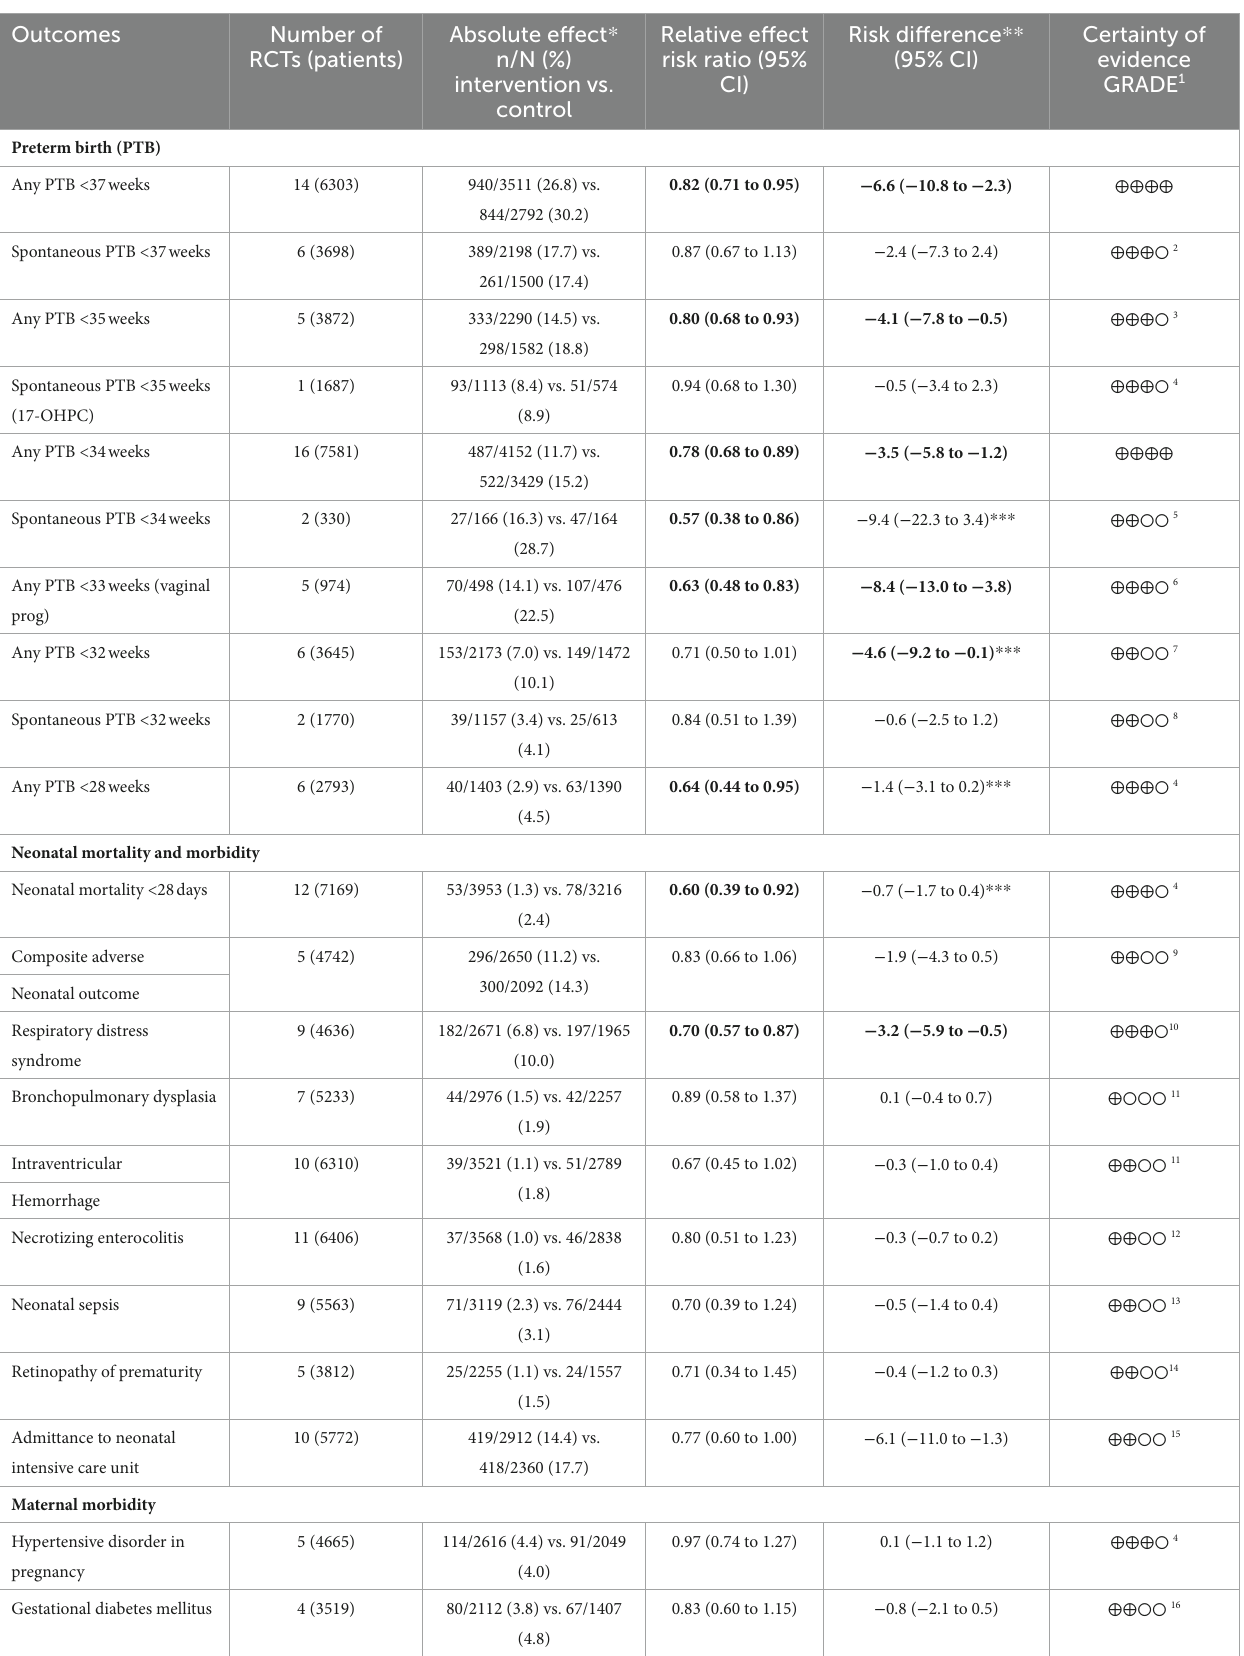
TABLE 2 Summary of findings for main outcomes (based on trials with low risk of bias): Progesterone (any administration route and dosage unless otherwise stated) vs placebo in women with a singleton pregnancy and any risk factor(s) for preterm birth.